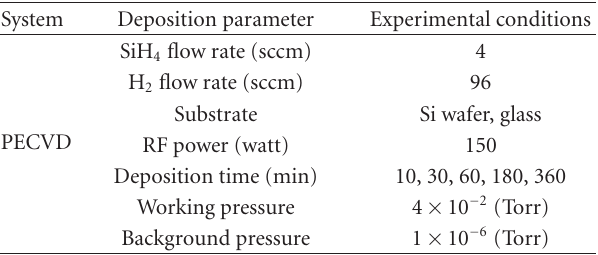
Table 1: Various deposition conditions of the nc-Si:H thin films.